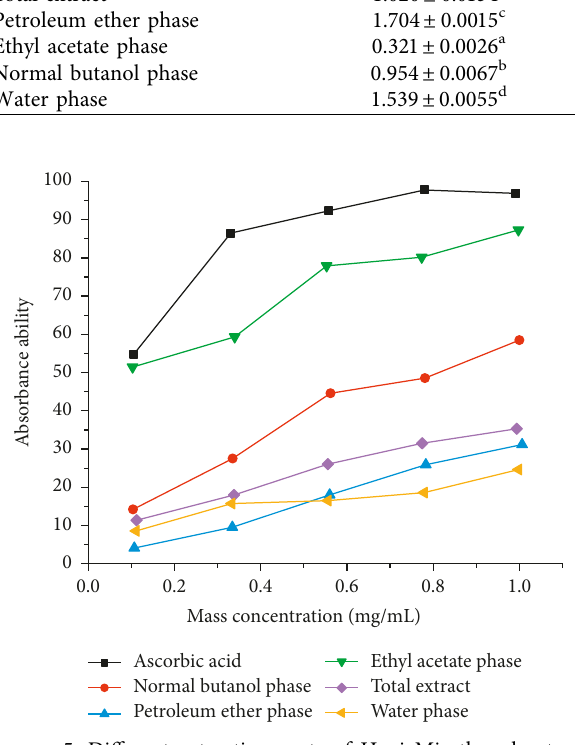
Figure 5: Different extraction parts of Huai Mi ethanol extract have the ability to remove ABTS+ · ( n � 3).